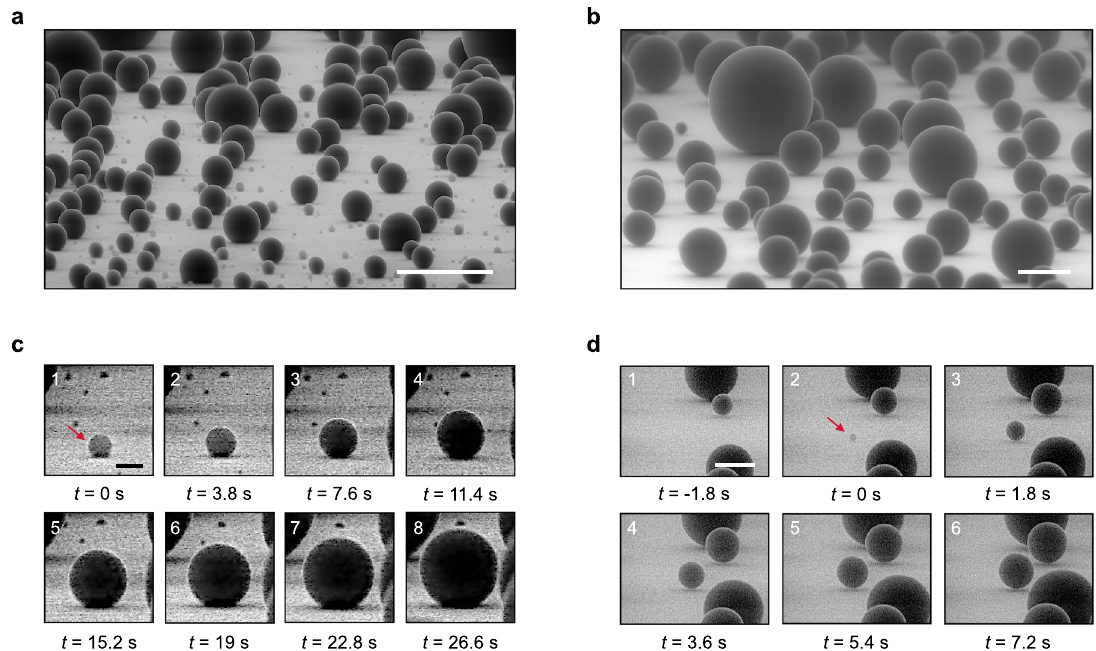
Fig. 2 Direct visualisation of droplets condensing on nanotexture. a ESEM images of water microdrops condensing on nanopillars (sample A; tilted by 85°). Drops adhere to the surface with contact angles no larger than 140°. The scale bar shows 20 µ m. b ESEM images of microdrops condensing on nanocones (sample E4; tilted by 80°). Contact angles are now ~170° for all drops (radii r between 1 µ m and 23 µ m). The scale bar shows 20 µ m. c Growth dynamics of an individual droplet (pointed by the arrow) on sample A. The drop is fi rst pinned (images 1 – 3) with a contact angle increasing from 120° to 140°, after which it keeps this value. Images are separated by 3.8 s, substrate temperature is T s = − 2.5 °C and chamber pressure P = 600 Pa. The scale bar shows 2 µ m. d Growth dynamics of a nucleus on sample E4. Starting with a contact angle of 130° ± 7° (image 2), the droplet quickly becomes a quasi- sphere with an angle of 171° ± 4°, proving a Cassie state even at a microscale. Images are separated by 1.8 s, temperature is T s = − 1.5 °C and pressure P = 700 Pa. The scale shows 2 µ